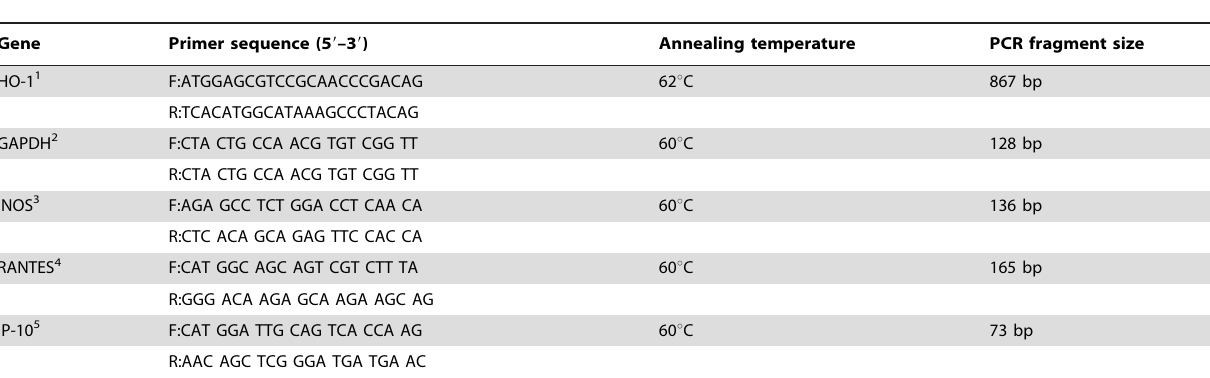
1 Homo sapiens heme oxygenase 1. 2 Glyceraldehyde-3-phosphate dehydrogenase. 3 Inducible nitric oxide synthase. 4 Regulated upon Activation, Normal T-cell Expressed, and Secreted (CCL5). 5 Interferon gamma-induced protein 10 (CXCL10). doi:10.1371/journal.pone.0046646.t001 PLOS ONE |